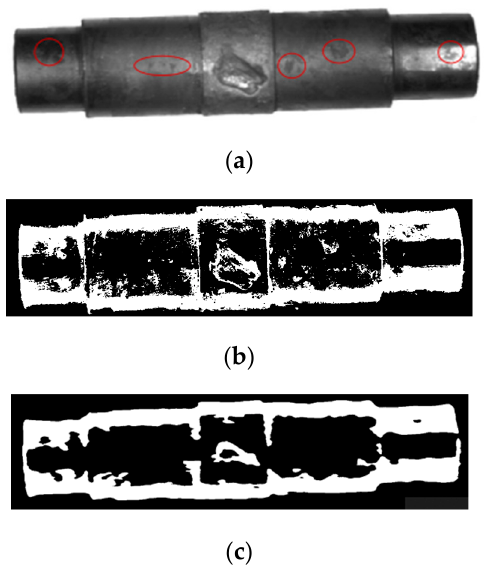
Figure 6. Binarization comparison. ( a ) Original image; ( b ) Binarized image; ( c ) Binarized image after filtering.